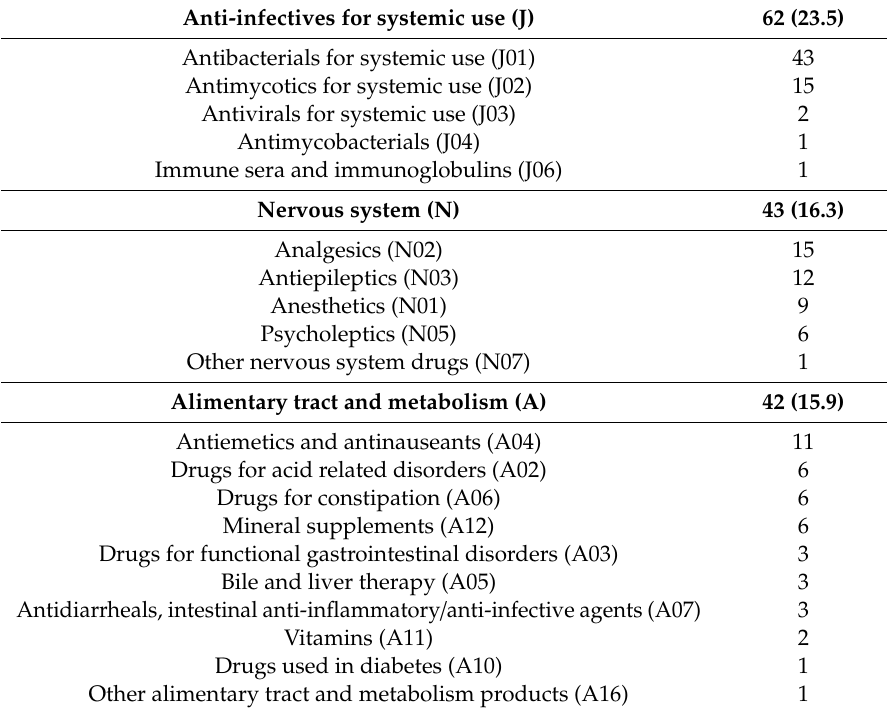
Table 4. Distribution of medicines reported as concomitant with tisagenlecleucel belonging to the top 3 drug classes, grouped by anatomical main group (1st level of ATC) and by therapeutic subgroup (2nd level of ATC). Anti-infectives for systemic use